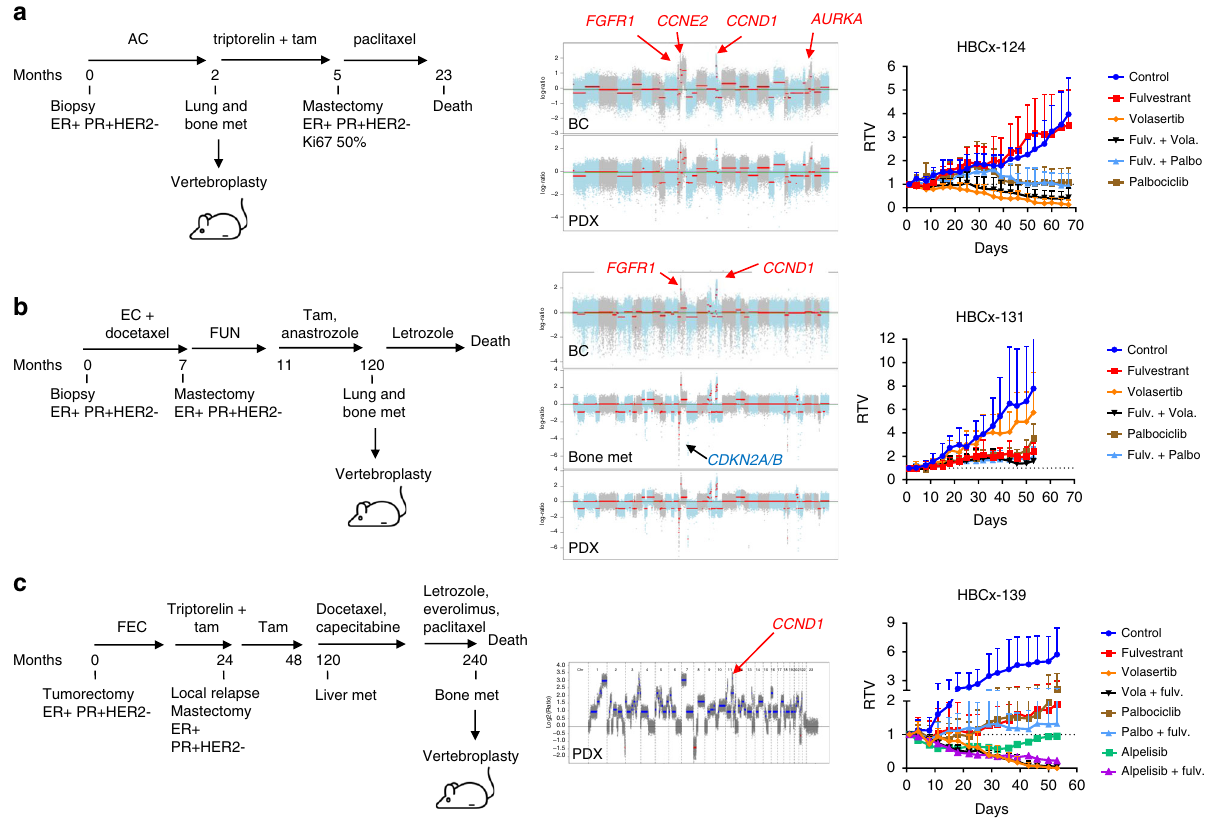
Fig. 2 Response to volasertib in CCND1 -driven PDX. a clinical history, genomic pro fi le and drug response of PDX HBCx-124. The HBCx-124 PDX